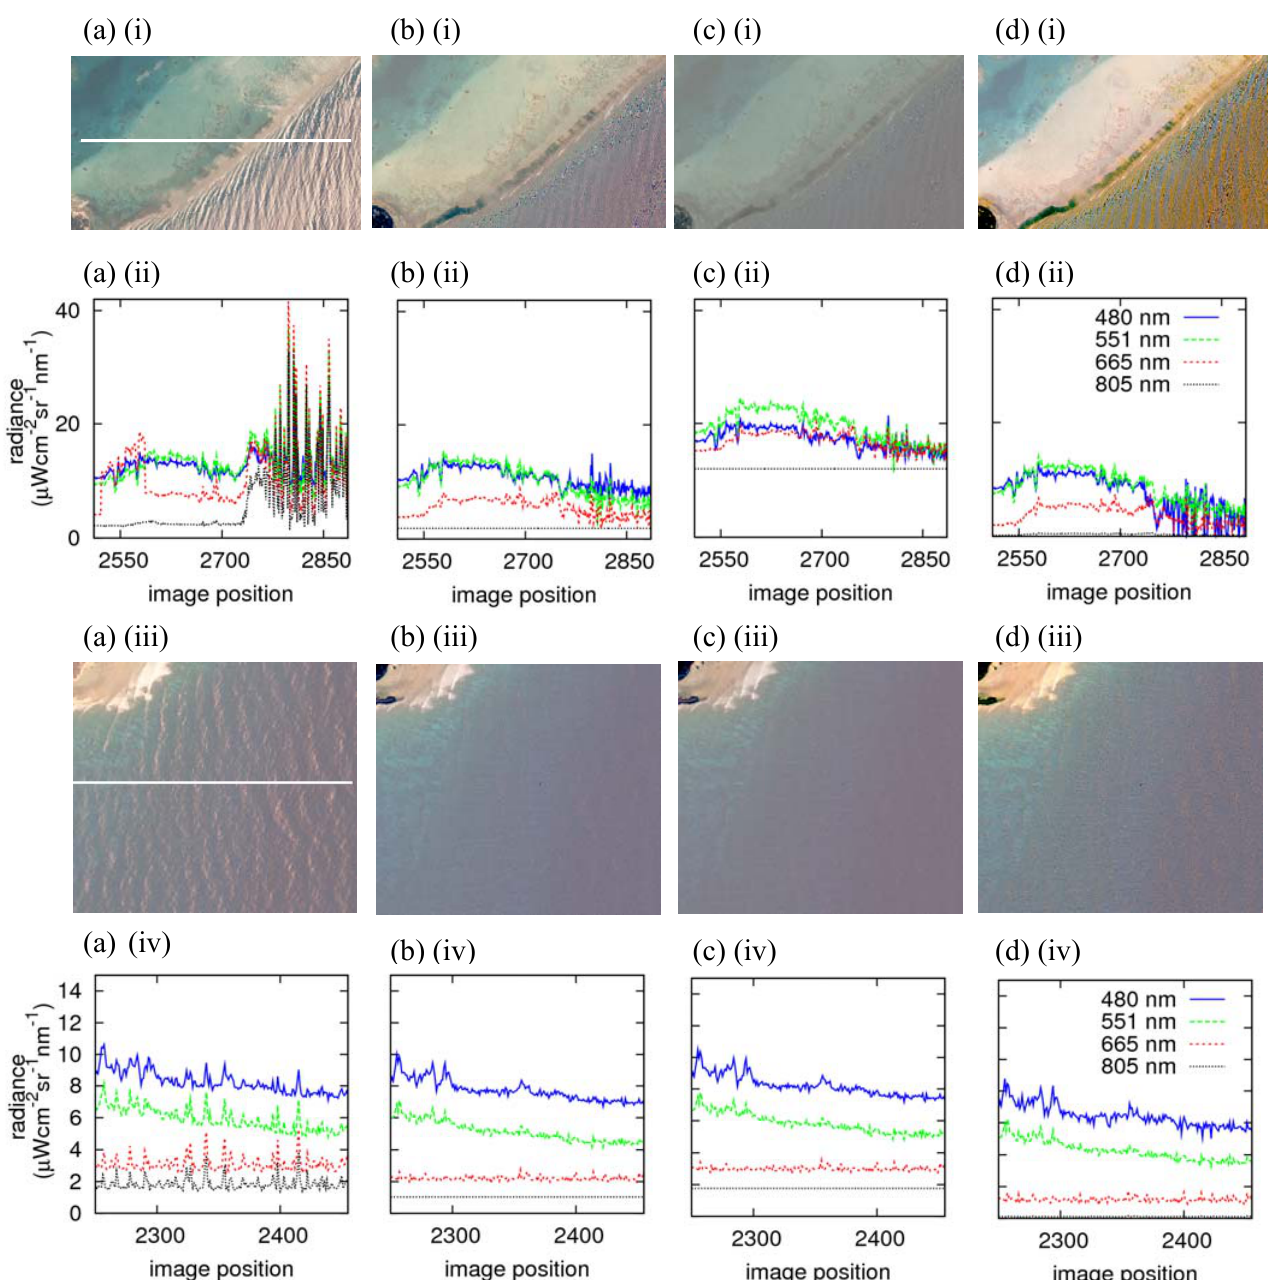
Figure 8. IKONOS images of Glovers’ Reef, Belize, showing the effects of different glint correction tools. (a) Image with no glint correction, showing regions used for correction and analysis. Image corrected using the method of (b) Hedley et al. (c) Lyzenga et al. (d) Goodman et al. In each case (i) is a pseudo-true color representation (blue = 445–516 nm, green = 506–595 nm, red = 632–698 nm), (ii) shows four wavebands for pixels along the lines shown in (a) (i), (iii) is another pseudo-true color image, less contaminated by glint and with greater magnification, (iv) shows four wavebands for the line in (a)